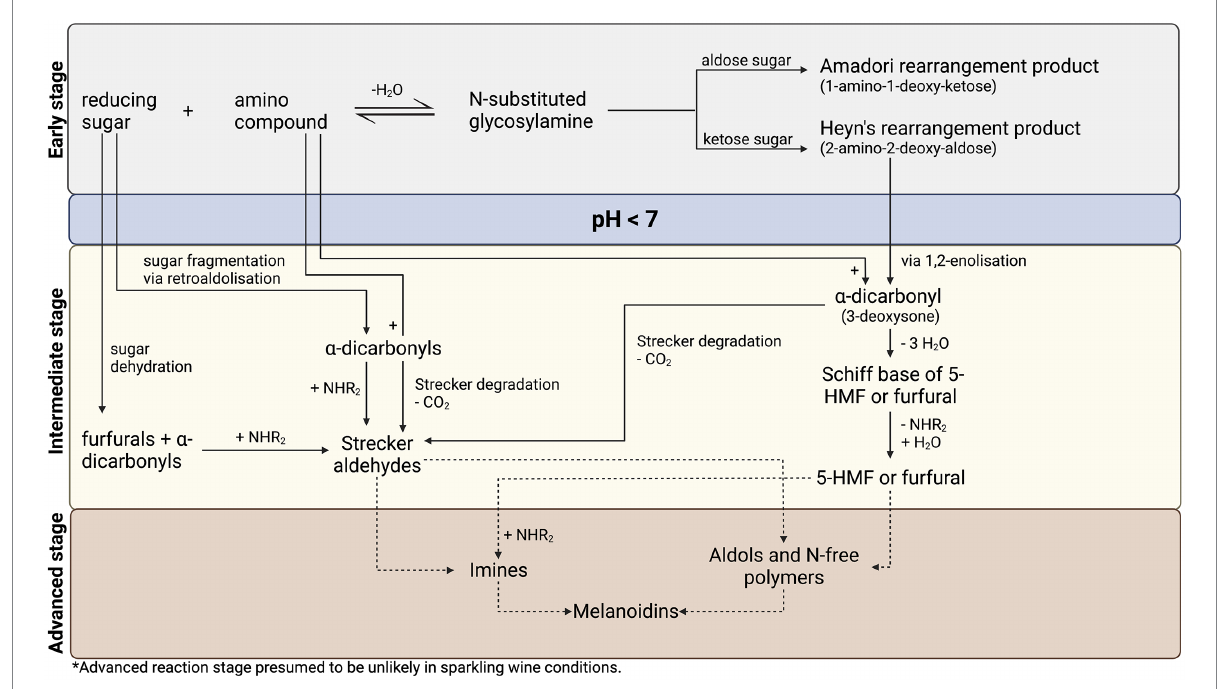
FIGURE 2 Proposed reaction pathway for the Maillard reaction in sparkling wine, adapted from Hodge (1953) and Nursten